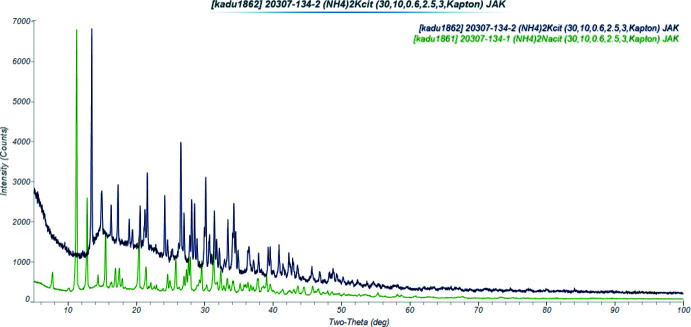
Comparison of the X-ray powder diffraction patterns of (II) (green) and (NH4)2KC6H5O7 (black).